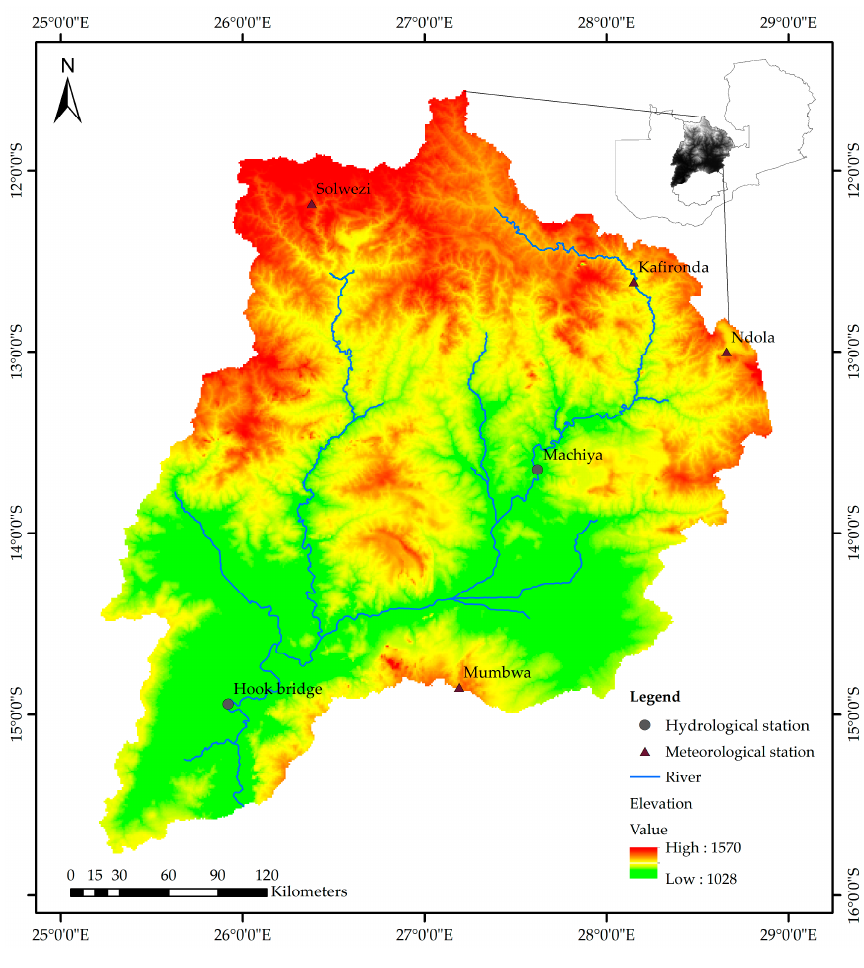
Figure 1. Study area, location and distribution of hydrological and meteorological stations.